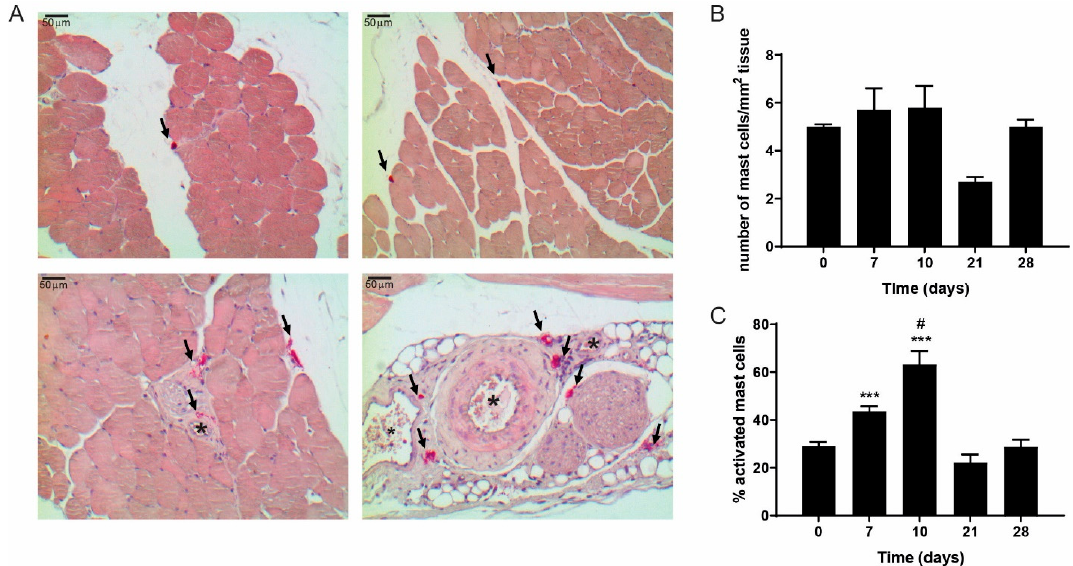
Figure 2. Mast cells in hind limb muscle tissue during ischemia in mice. ( A ) Representative images of mast cells in pink (CAE staining, indicated by arrows) in mouse ischemic muscle tissue (upper panels) and in close proximity to blood vessels (lower panels, indicated by *). ( B ) Mast cell density and ( C ) the percentage of activated mast cells in the hind limb muscle during recovery after ischemia. p -values of < 0.001 in comparison to t0 are indicated by *** p -value of < 0.05 in comparison to t7 is indicated by #.